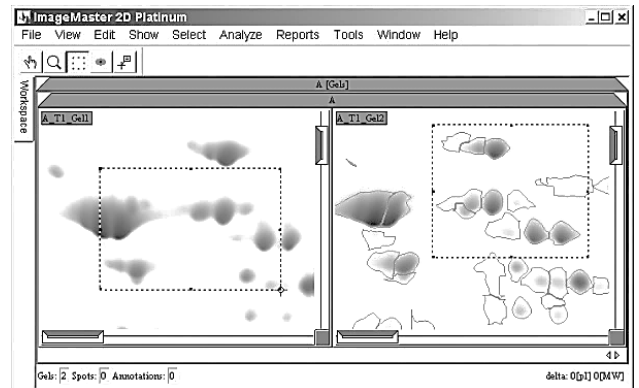
Fig. 3. Intermediate result of images 2-DE analysis which detects stained fractions (spots) automatically.